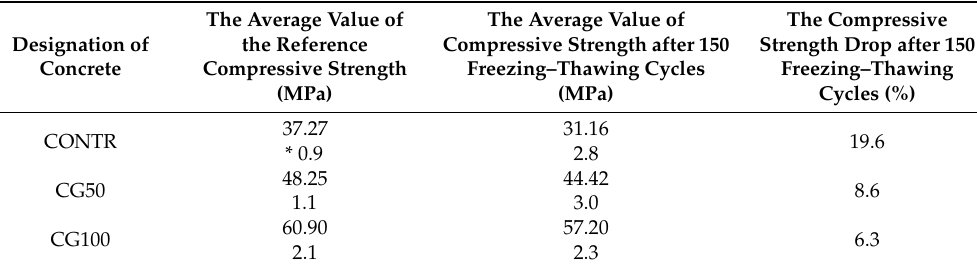
Table 5. The results of frost resistance test of concrete with the